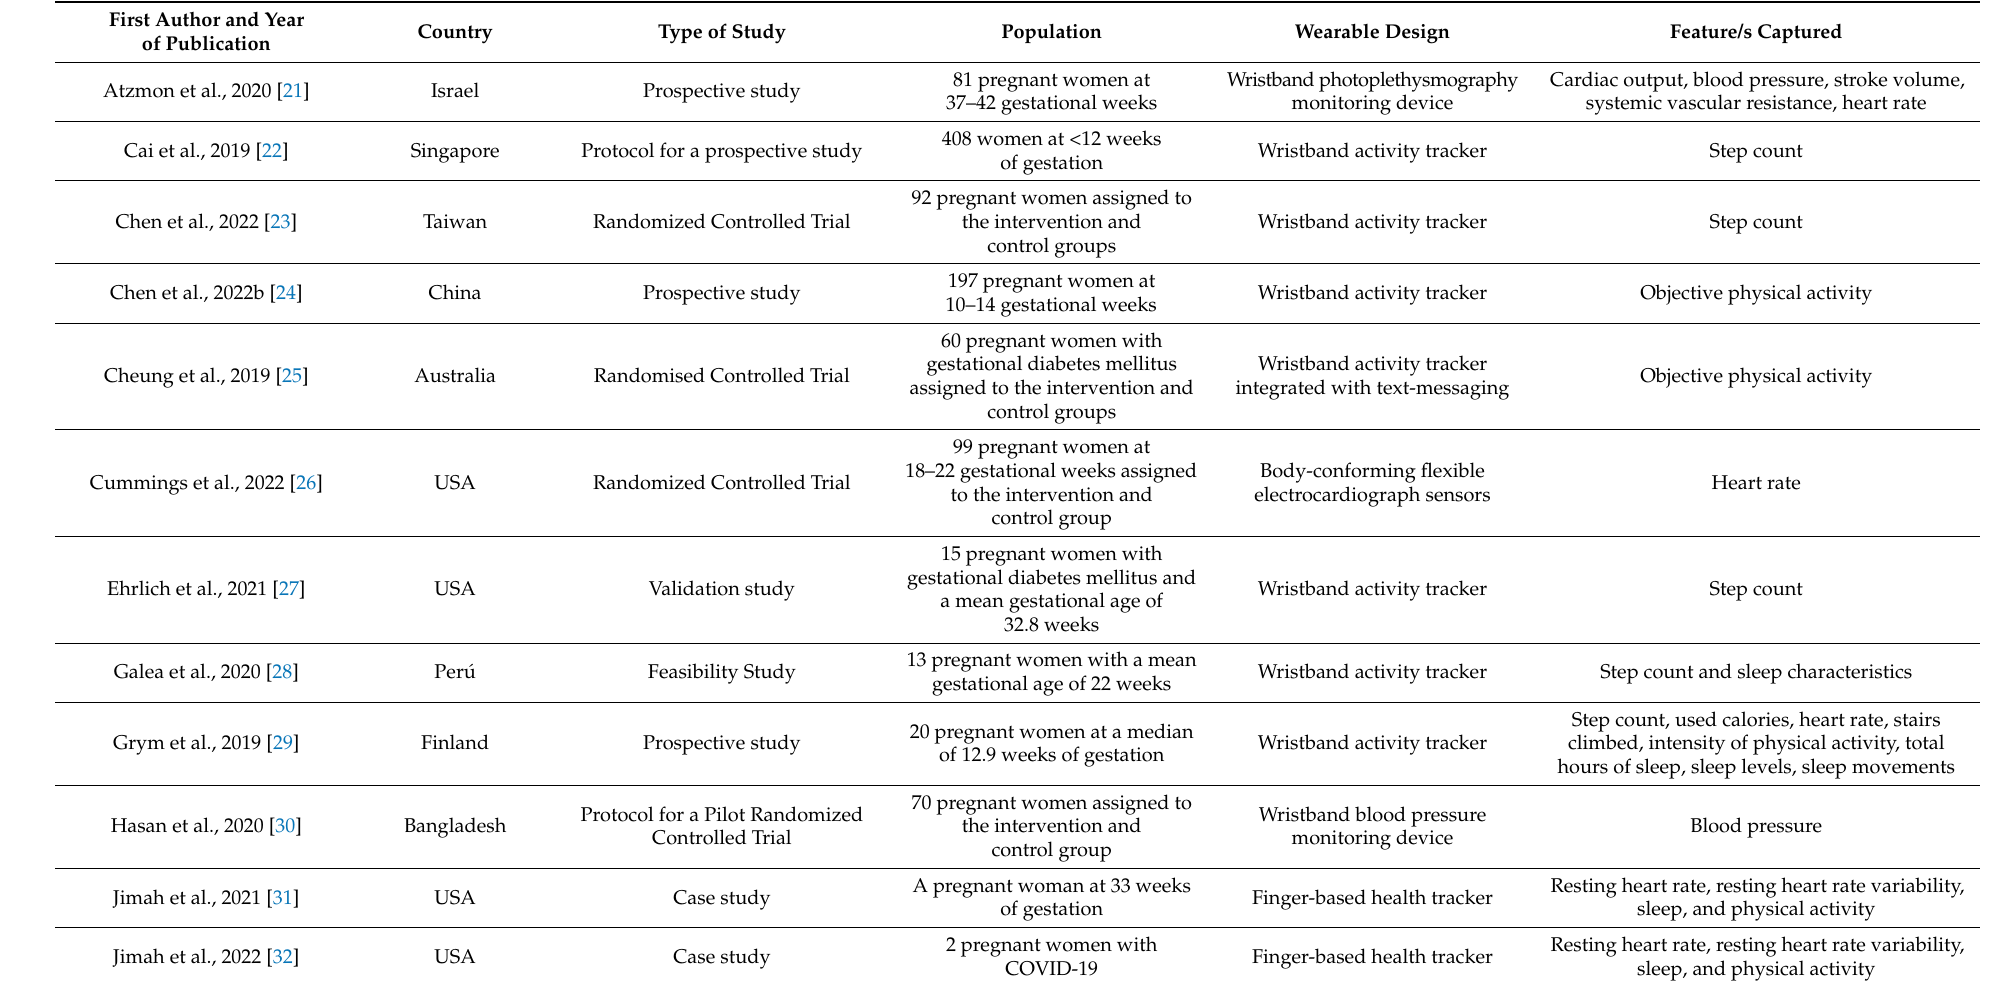
Table 2. Characteristics of studies using wearable devices for maternal parameters and